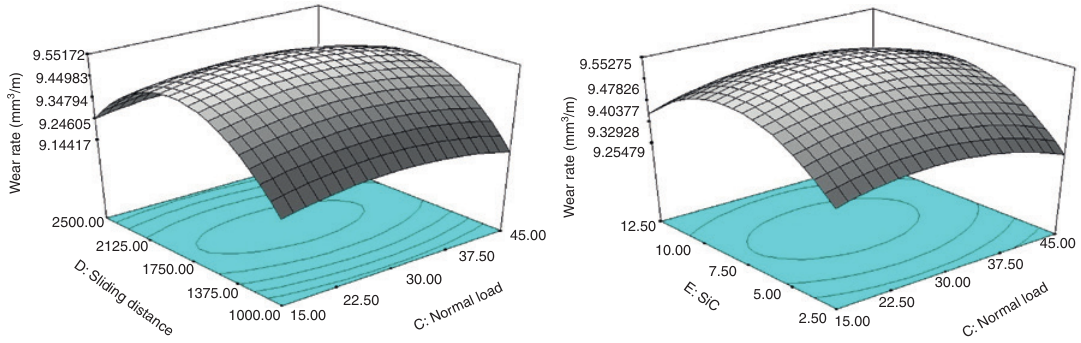
Figure 11: Interactions of normal load with sliding distance and SiC wt.% to reduce wear